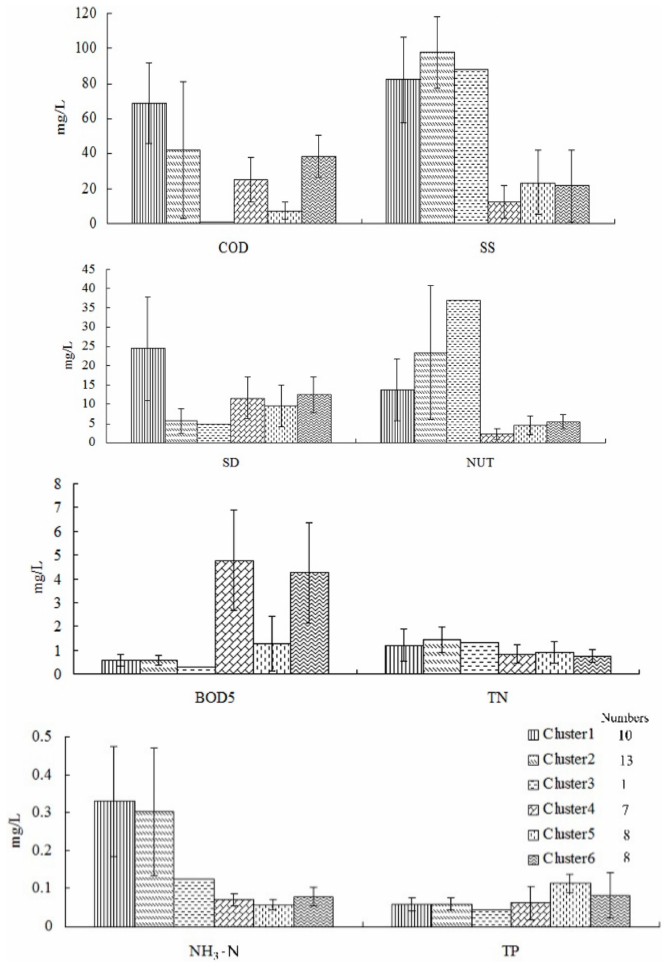
Figure 5. Average values for the water quality